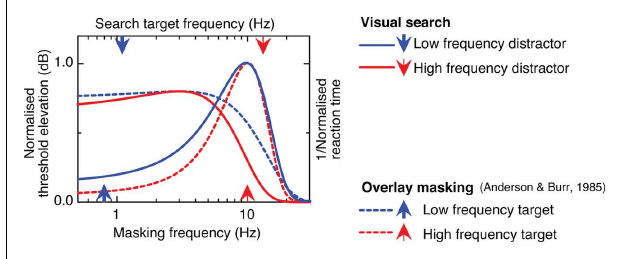
FIGURE 3 | Comparison of psychophysical temporal frequency channels derived using a classic overlay masking paradigm (dashed curves) and Gaussian-fitted average search times (Experiment 1: set size = 11 items) resulting from differences in target–distractor flicker rate (solid